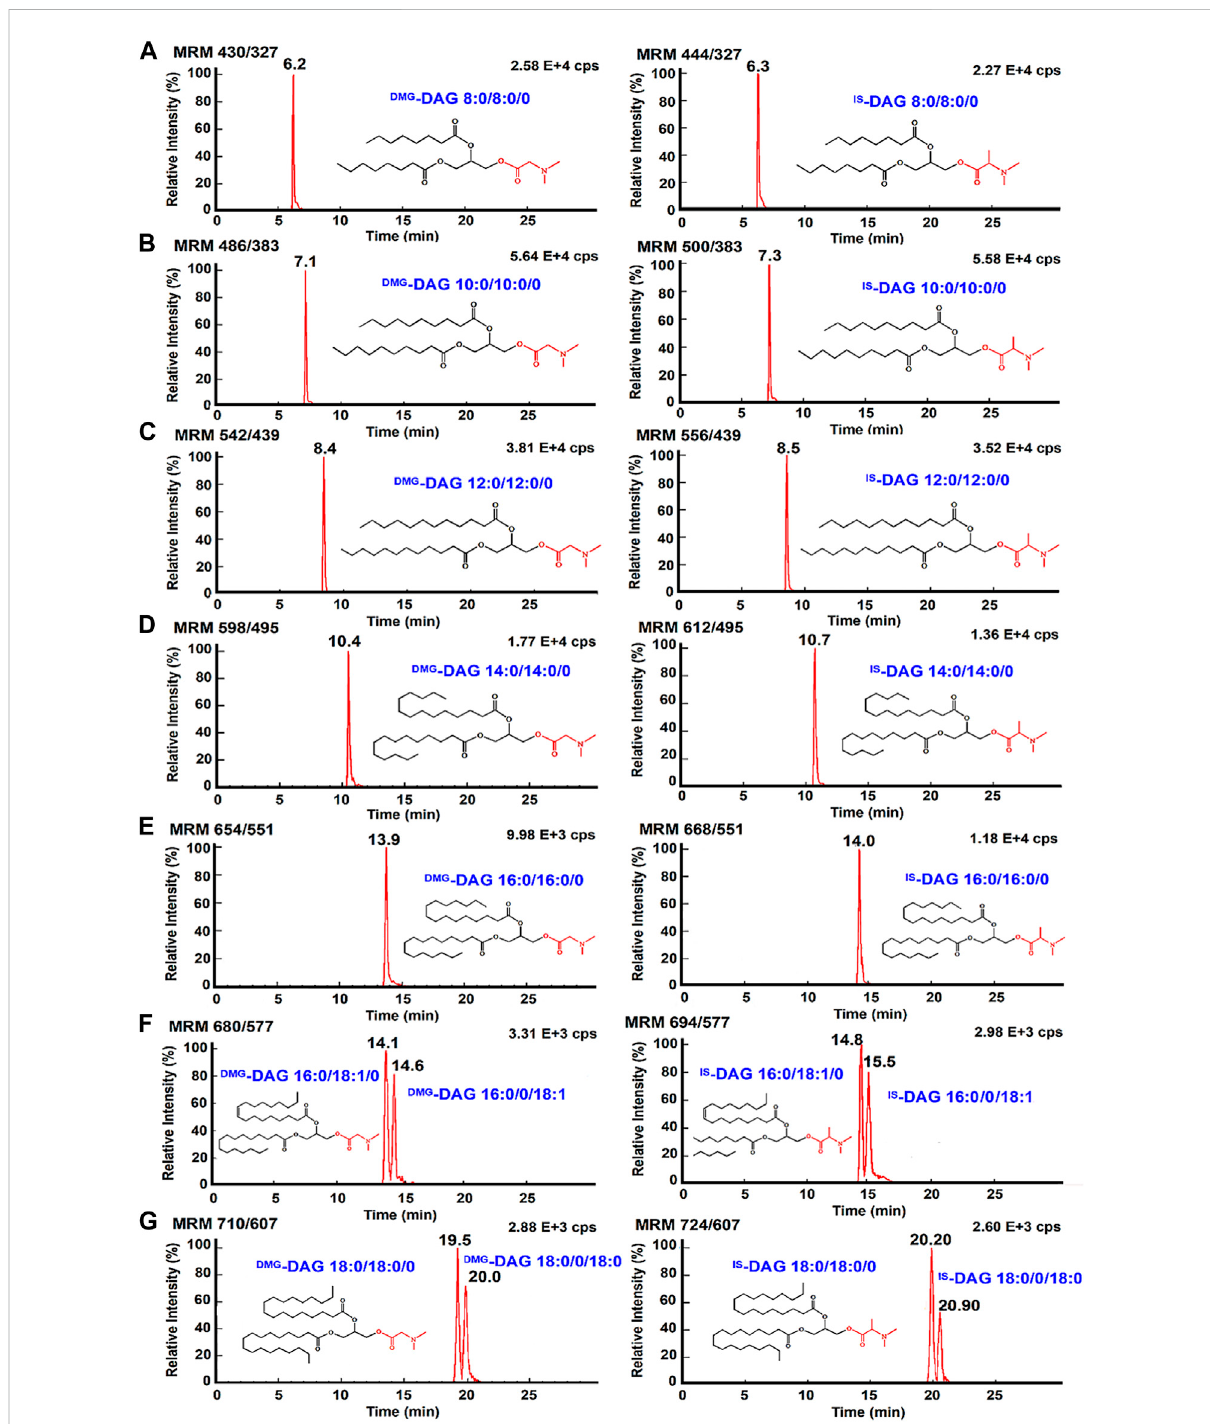
FIGURE 6 ThechromatogramofDAGs,showingseparationof sn -1,2DAGsand sn -1,3DAGs.UPLC-MS/MS chromatogramof (A) DMG -DAG8:0/8:0/0and IS -DAG 8:0/0/8:0; (B) DMG -DAG 10:0/10:0/0and DMA -DAG 10:0/0/10:0; (C) DMG -DAG 12:0/12:0/0 and DMA -DAG 12:0/12:0/0; (D) DMG -DAG 14:0/14:0/ 0 and DMA -DAG 14:0/14:0/0; (E) DMG -DAG 16:0/16:0/0 and DMA -DAG 16:0/16:0/0; (F) DMG -DAG 16:0/18:1/0, DMG -DAG 16:0/0/18:1, DMA -DAG 16:0/18: 1/0 and DMA -DAG 16:0/0/18:1; (G) DMG -DAG 18:0/18:0/0, DMG -DAG 18:0/0/18:0, DMA -DAG 18:0/18:0/0 and DMA -DAG